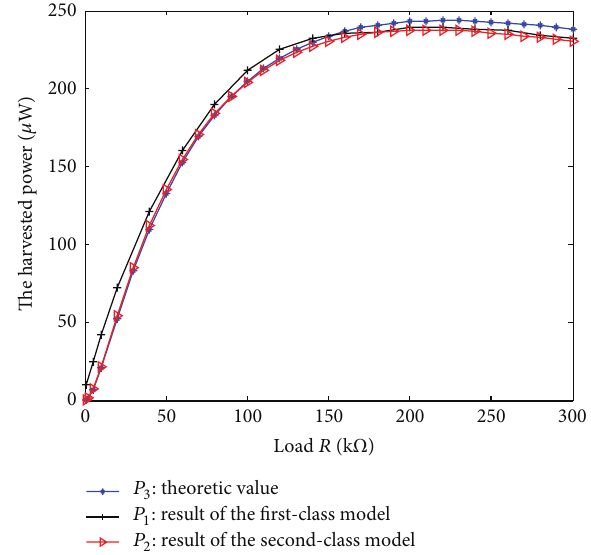
Figure 9: Comparison of harvested powers from the two classes of coupled models.